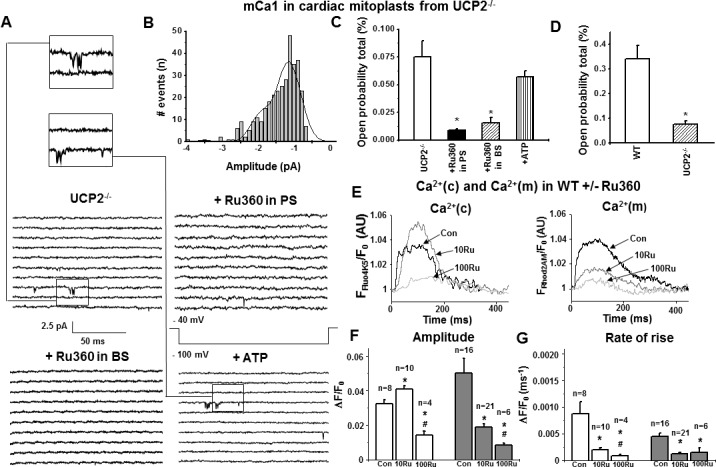
a) Examples of consecutive original traces of cardiac mCa1 in mitoplasts from UCP2-/-: mCa1 in UCP2-/- vs. mCa1 in UCP2-/- + Ru360 (200 nM) in PS vs. mCa1 in UCP2-/- + Ru360 (10 μM) in BS vs. mCa1 in UCP2-/- + ATP (1 mM) in BS. b) Amplitude histogram of basic mCa1 in cardiac UCP2-/- mitoplasts. Basic mCa1 in UCP2-/- showed three amplitude levels with -1.19±0.04 pA being the most common observed amplitude [Iunitary: -1.19±0.04 pA, n = 23; μ1: -1.16 pA (78%), μ2: -1.95 pA (21%), μ3: -3.51 pA (1%)]. c) In cardiac mitoplasts from UCP2-/- Ru360 (200 nM) in pipette solution (PS, n = 7) and Ru360 (10 μM) in bath solution (BS, n = 4) significantly decreased total open probability (Po, total) of mCa1 (*p<0.05). ATP (1 mM, n = 7) had no effect on mCa1 activity in UCP2-/-. d) Total open probabilities (Po, total) of basic mCa1: In comparison to WT mCa1, Po,total of mCa1 in UCP2-/- was significantly decreased (*p<0.05). e-g) Ca2+ transients in WT cardiomyocytes (Con) ± 10 and 100 nM Ru360. e) Representative traces of (Ca2+)c (left) and (Ca2+)m (right), f-g) Statistical analysis: In WT cardiomyocytes 10 nM Ru360 (10Ru) significantly elevated amplitude while (Ca2+)c rate of rise was decreased. 100 nM Ru360 (100Ru) suppressed both parameters. In mitochondria amplitude and rate of rise of (Ca2+)m were significantly decreased using either 10 or 100 nM Ru360. *p<0.05 vs. Con; #p<0.05 vs. Con + 10 nM Ru360.